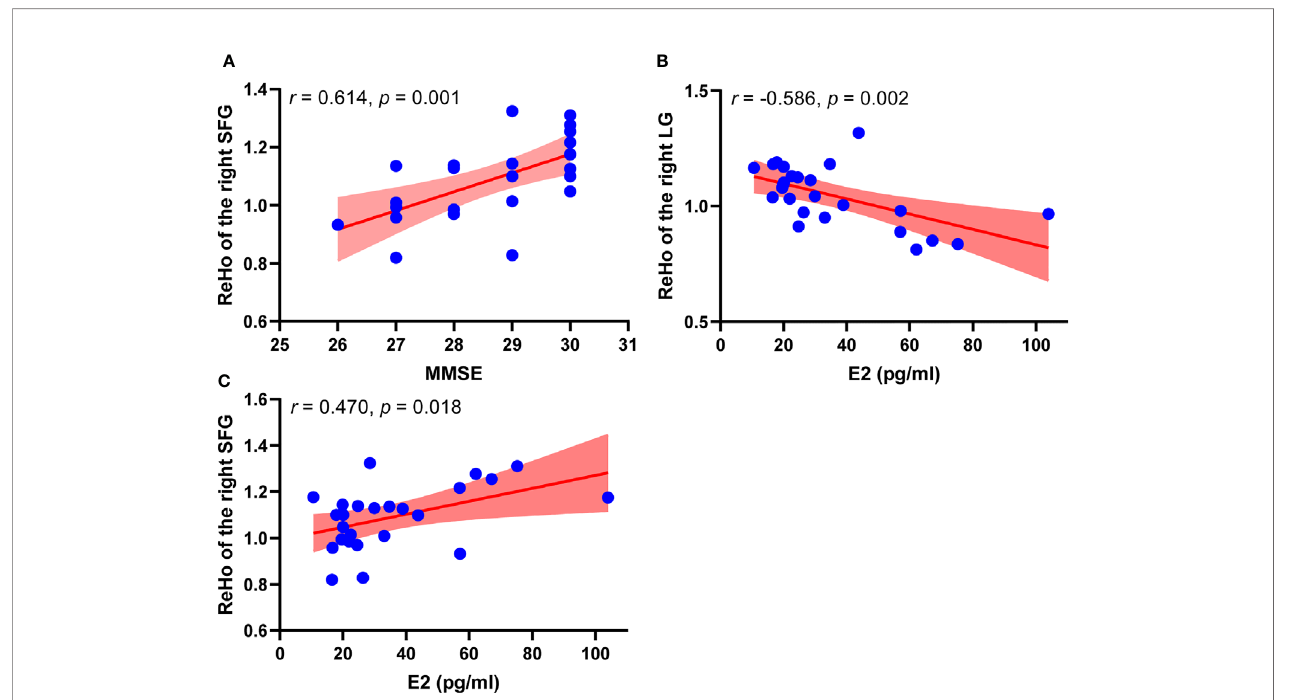
FIGURE 2 | Correlation analysis results between ReHo values and clinical information in perimenopausal group (n = 25). (A) Scatter plots between ReHo value of the right SFG and MMSE in perimenopausal women. (B) Scatter plots between ReHo value of the right LG and level of E2 in perimenopausal women. (C) Scatter plots between ReHo value of the right SFG and level of E2 in perimenopausal women. MMSE, Mini-Mental State Examination, LG; lingual gyrus, E2, estradiol; ReHo, regional homogeneity; SFG, superior frontal